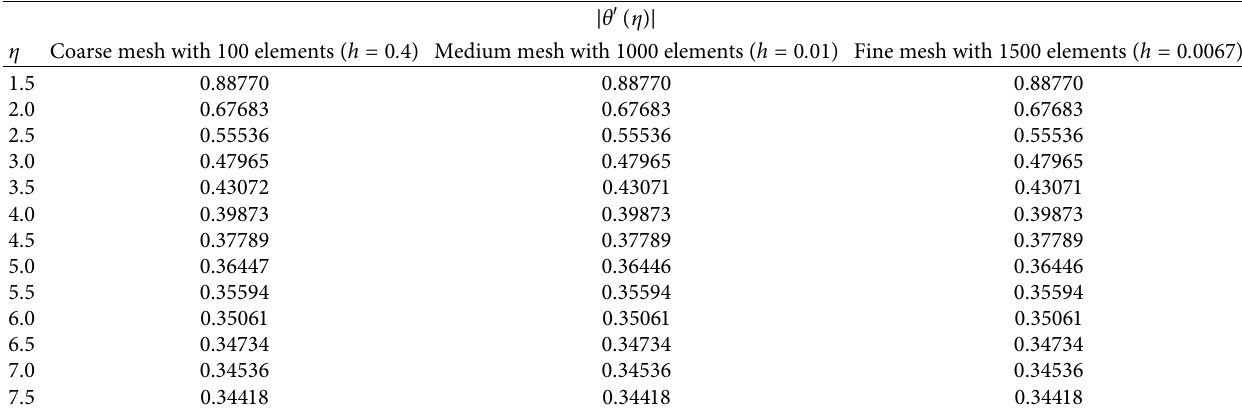
Table 3: Grid-independence test for temperature